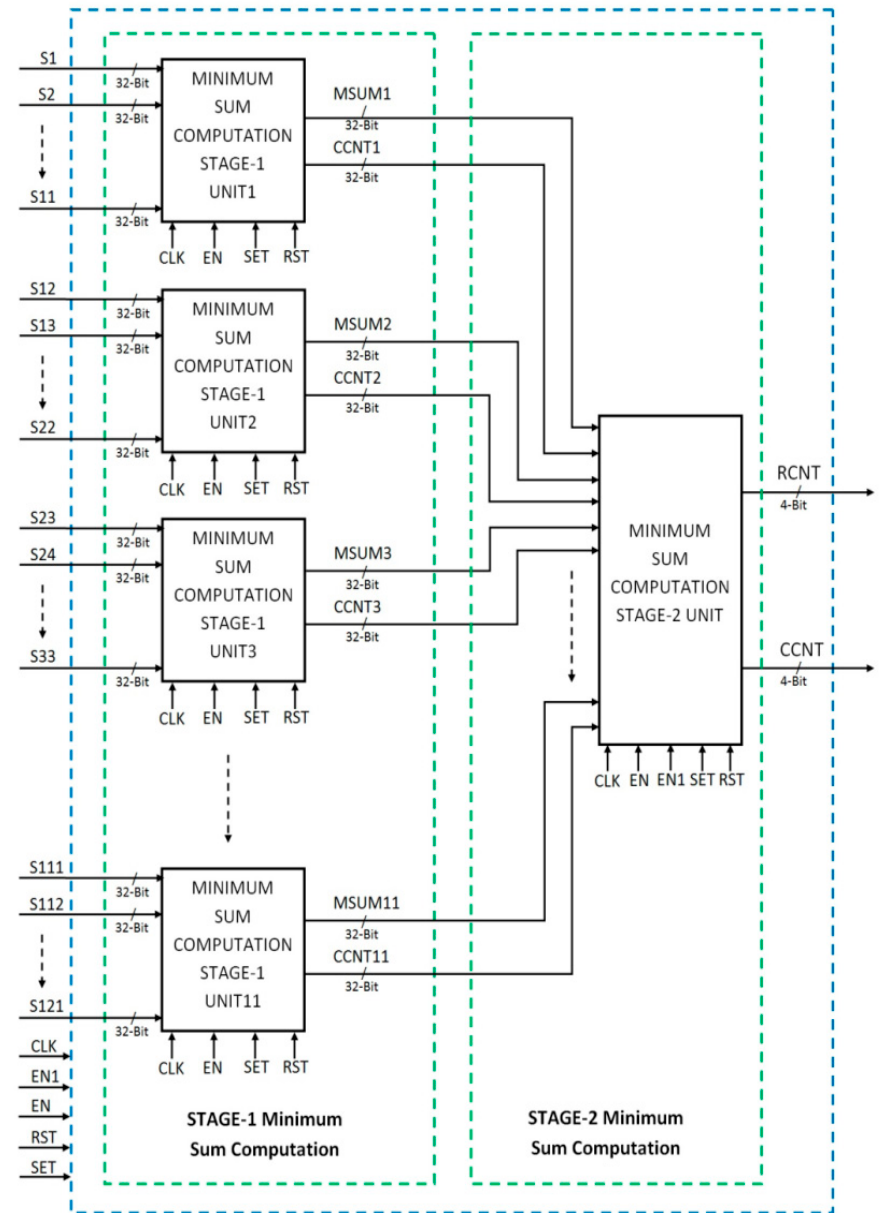
Figure 9. Architecture of minimum sum value computation module. S → Sum Value; MSUM → Minimum Sum Value; CCNT → Column Counter; RCNT → Row Counter.